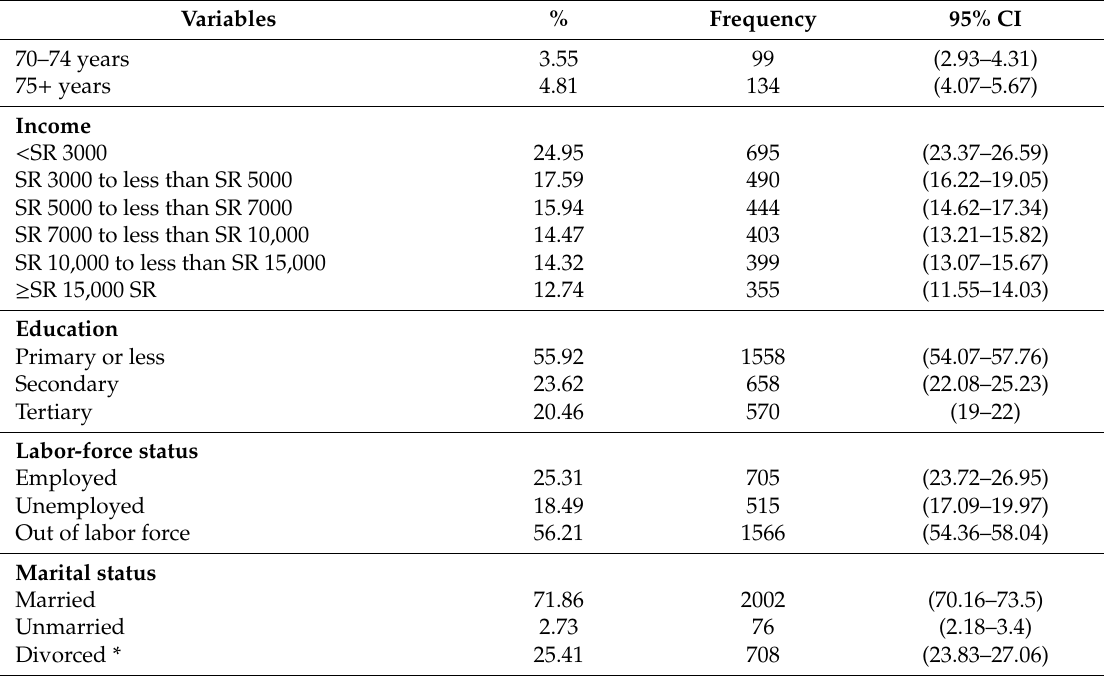
Figure 2. Concentration curves of breast cancer screening uptake by education and income. Tables 3 and 4 present the estimates of socioeconomic inequalities measured by the standard concentration index (C), Wagstaff’s index (W), and Erreygers’s index (E). All estimates were positive and statistically significant ( p < 0.001). This suggests that inequalities in the three outcomes were in favor of women from richer households and better-educated women. These findings confirm inequalities illustrated by the CCs. Overall, the magnitudes of education-related inequality were higher than income-related inequalities in breast cancer screening uptake. Inequalities in the self-